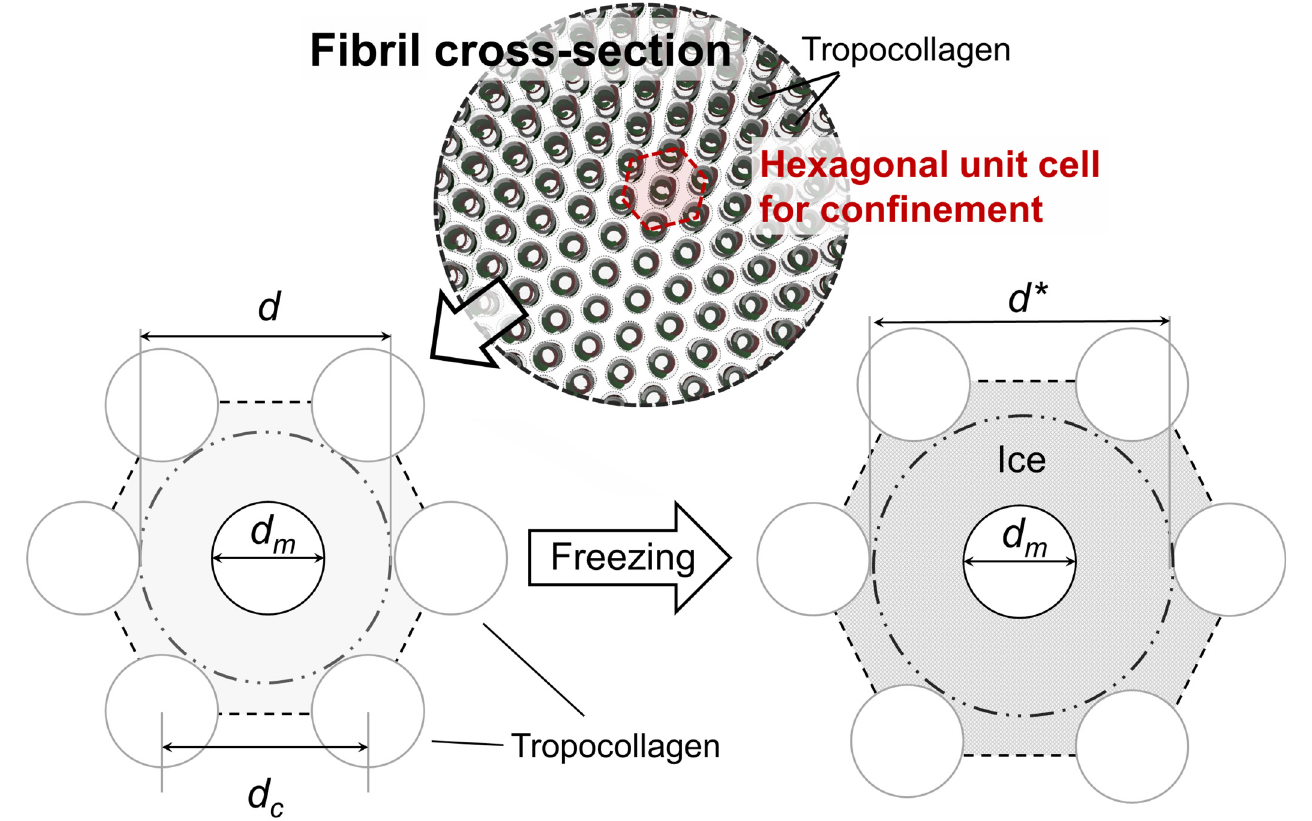
Fig 1. Freezing-induced expansion of collagen fibril. Average confinement of single collagen molecule in the fibril is modeled by considering an equilateral hexagonal unit cell for confinement based on a quasi-hexagonal packing state [44, 45]. Unit cell expands as intrafibrillar fluid freezes. d m is tropocollagen nominal diameter, d is confinement diameter, d c is the length of a side of the unit